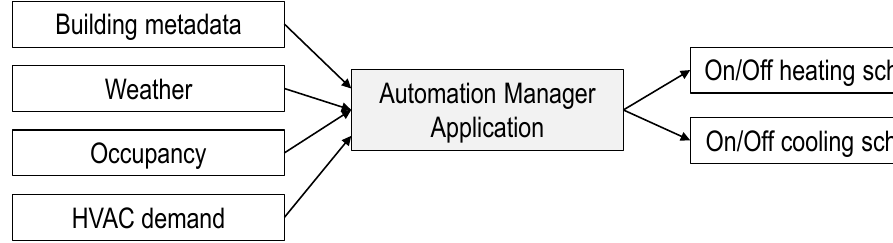
Figure 21. Block scheme of the automation manager